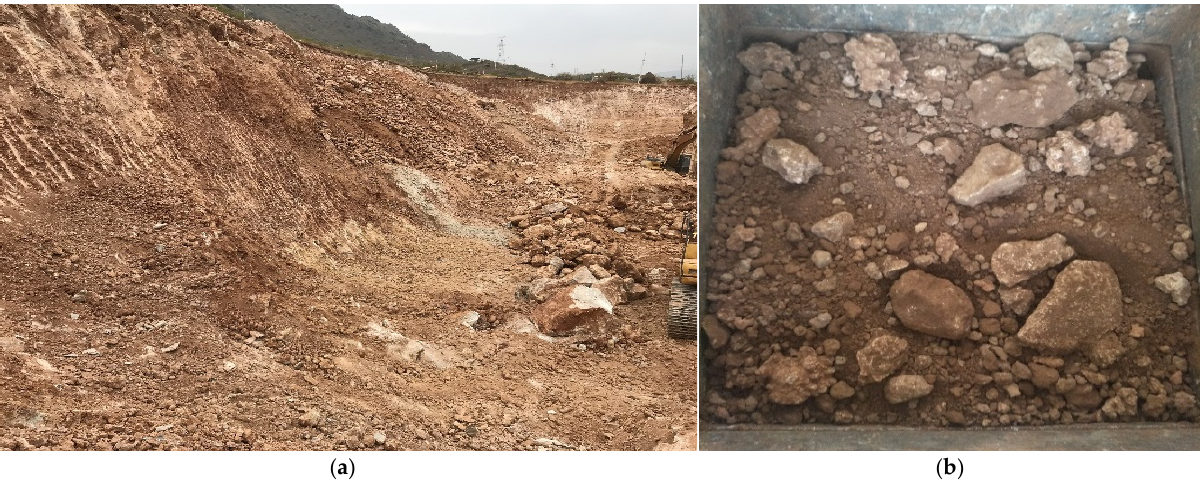
Figure 1. SRM in Zhaizi village, Lijiang City, Yunnan Province, China. ( a ) Site investigation; ( b ) SRM sample.